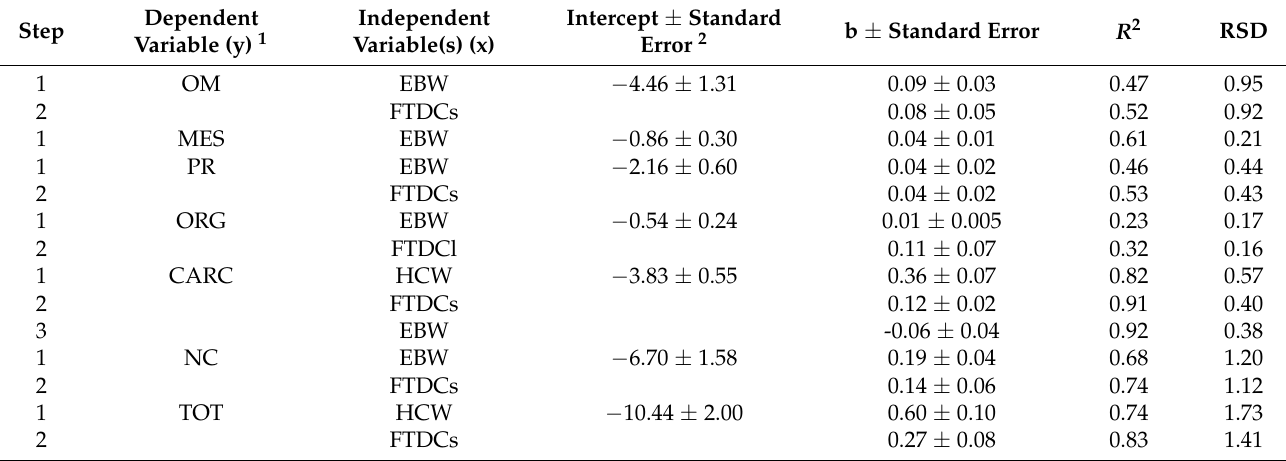
All regressions are significant at p < 0.05. 1 OM = omental fat; MES = mesenteric fat; PR = perirenal fat; ORG = organ fat (heart, liver, and lungs); CARC = carcass fat; NC = non-carcass fat; TOT = total fat depot (TOT = CARC + NC). 2 The intercept is the same within each group of equations predicting the same dependent